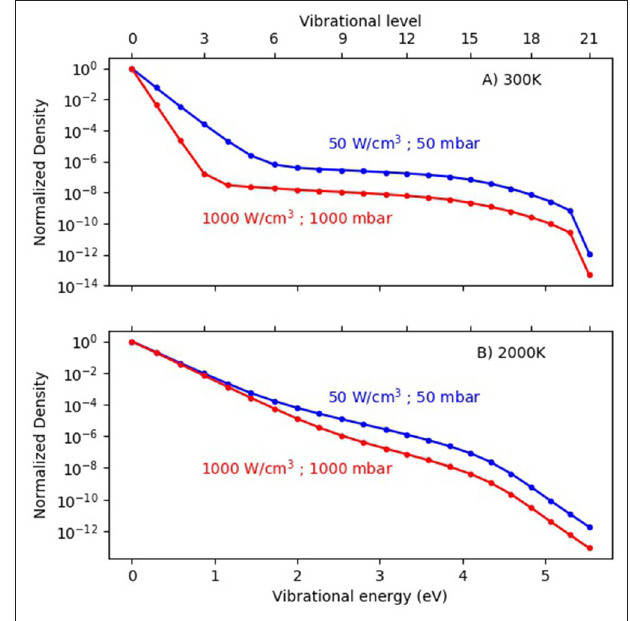
FIGURE 8 | Calculated vibrational distribution functions (VDFs) in a MW plasma, for a gas temperature of 300K (A) and 2,000K (B) , at two different pressures and power densities. Adopted from Berthelot and Bogaerts (2017) with